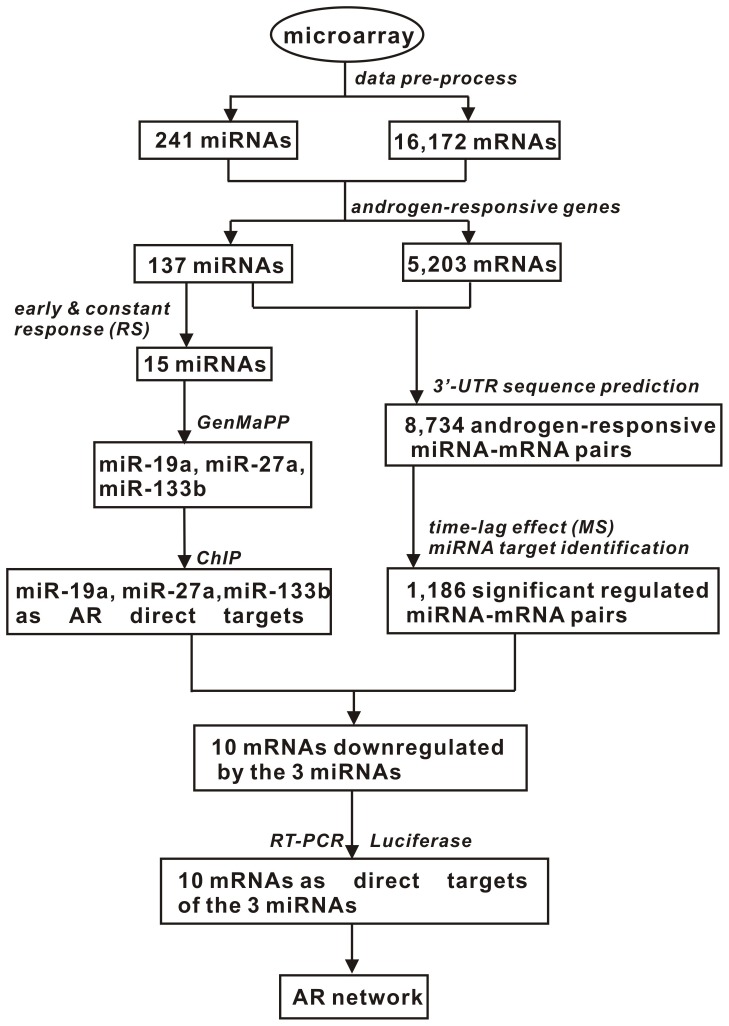
Flowchart of strategy.This is the outline of the whole procedure for analysing microarray data to construct AR network in this study. Detailed steps are provided in the methodology and result sections.